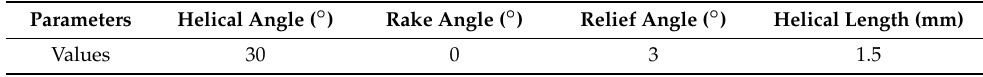
Figure 1. Flank face surface morphologies of differently coated micro end mills. ( a ) Uncoated micro end mill; ( b ) AlCrN-based coated micro end mill; ( c ) AlTiN-based coated micro end mill; ( d ) TiN coated micro end mill. Table 1. Tool geometries of the micro end mills.